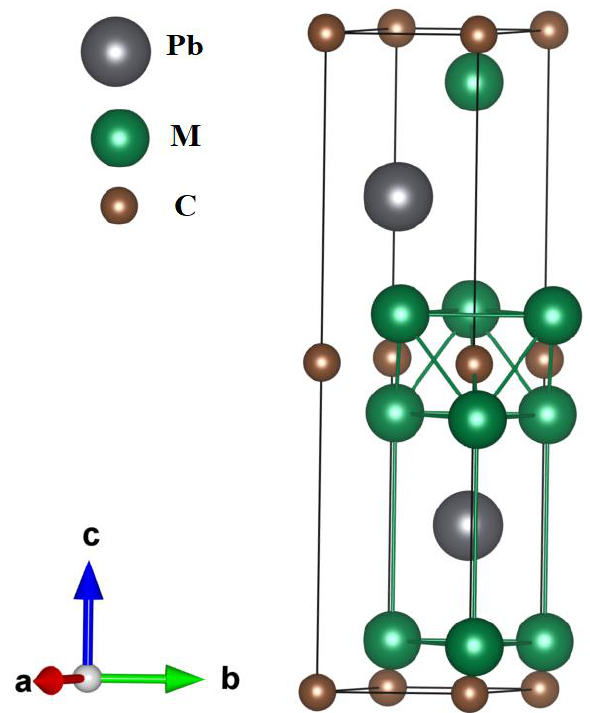
Figure 1. The unit cell of the M 2 PbC MAX phase (M = Ti, Zr, Hf) with the [M 6 X] octahedron and the [M 6 A] trigonal prism. Table 1. The equilibrium lattice parameters a and c, volume V, and relaxed atomic parameter ZM and the formation energy (∆Ef) for M 2 PbC (M = Ti, Zr, Hf).